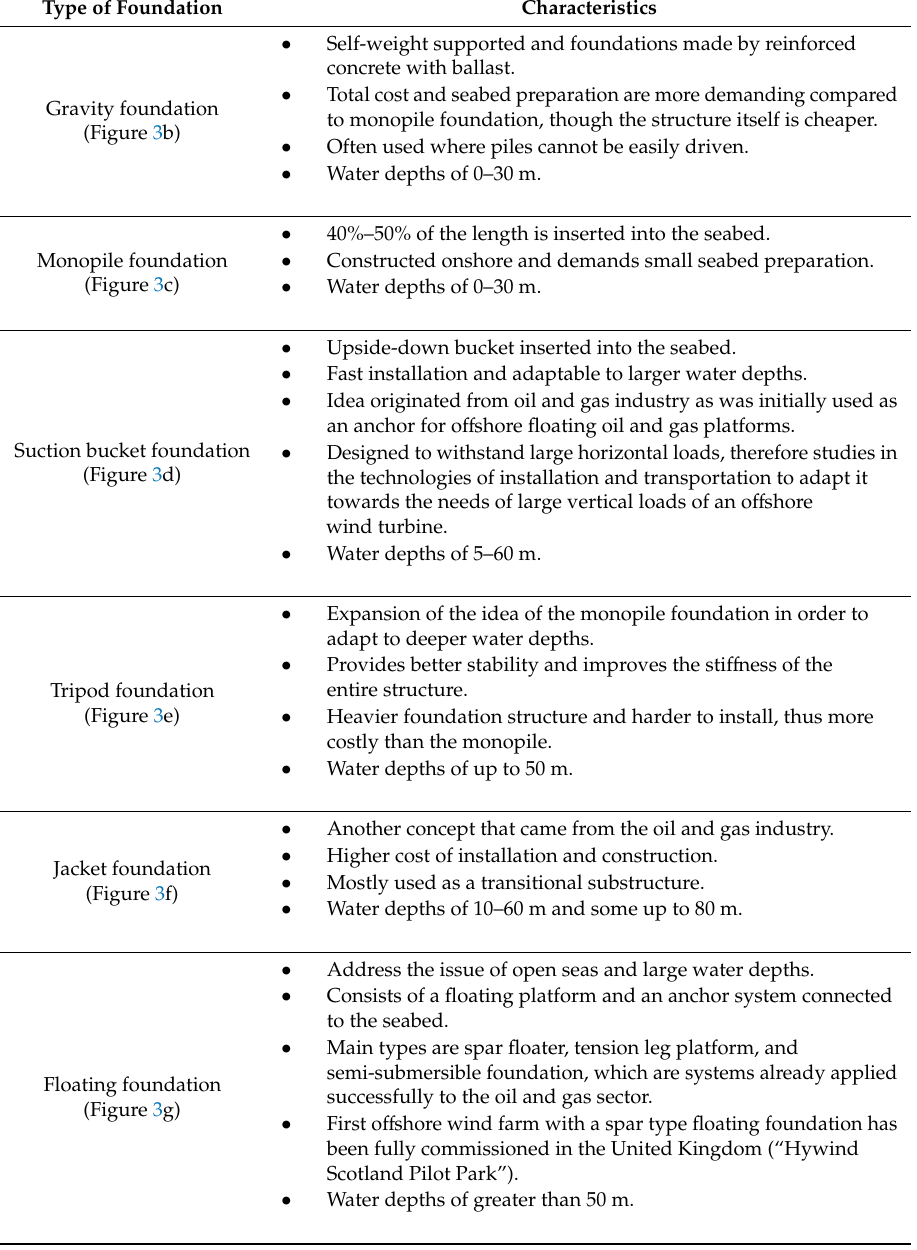
Table 1. O ff shore wind turbine foundation types and their